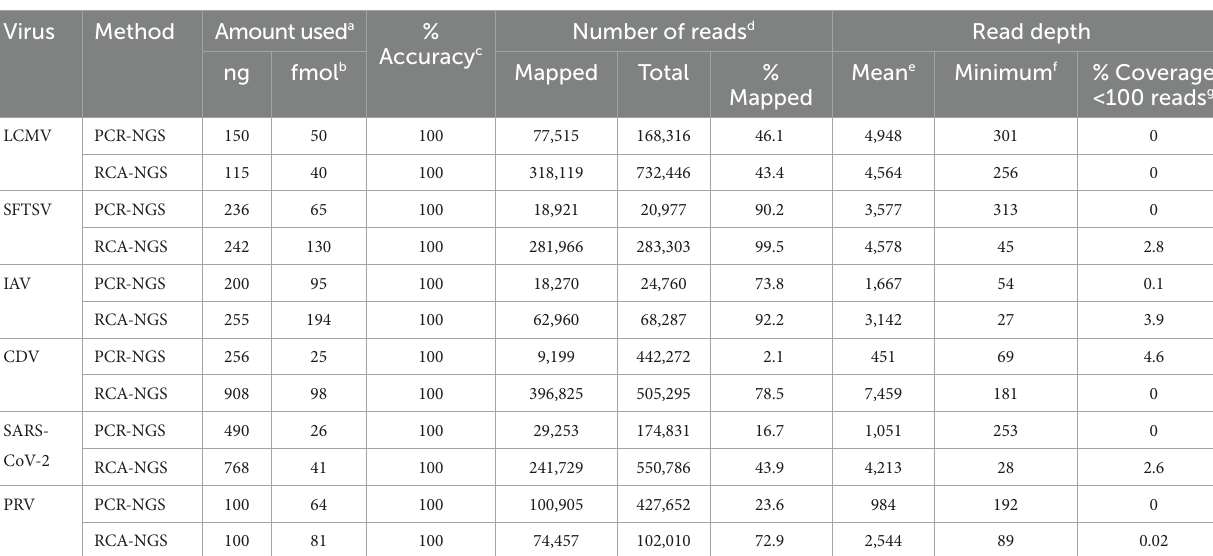
TABLE 3 NGS results.